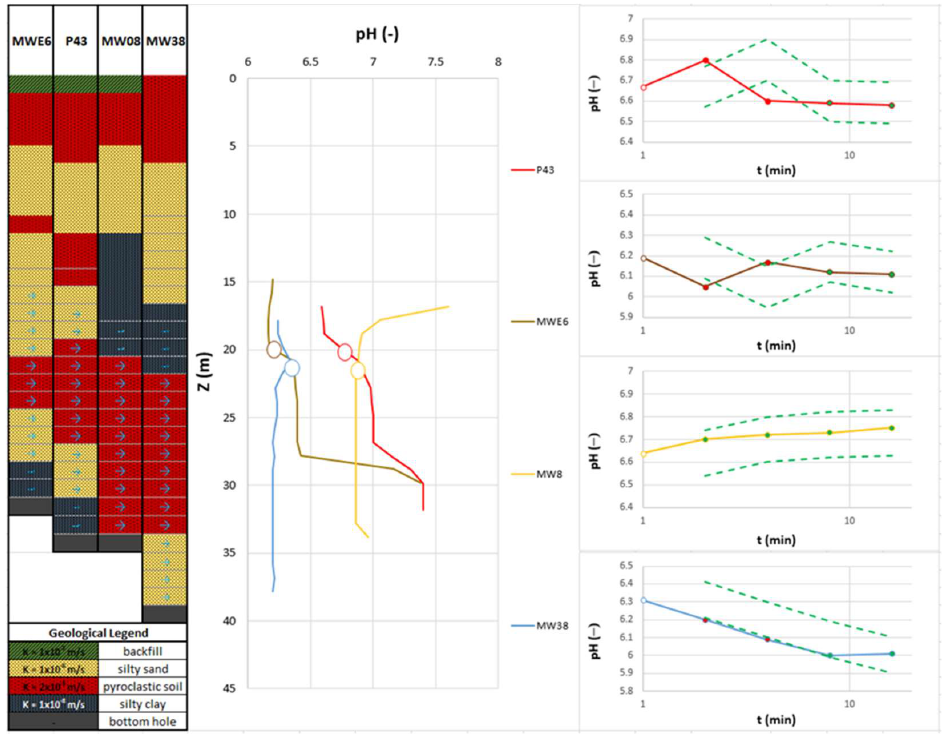
Figure 7. Layout of coupled log-purging (z-t) pH results for high-heterogeneity well types (MWE6, P43, MW8 and MW38).